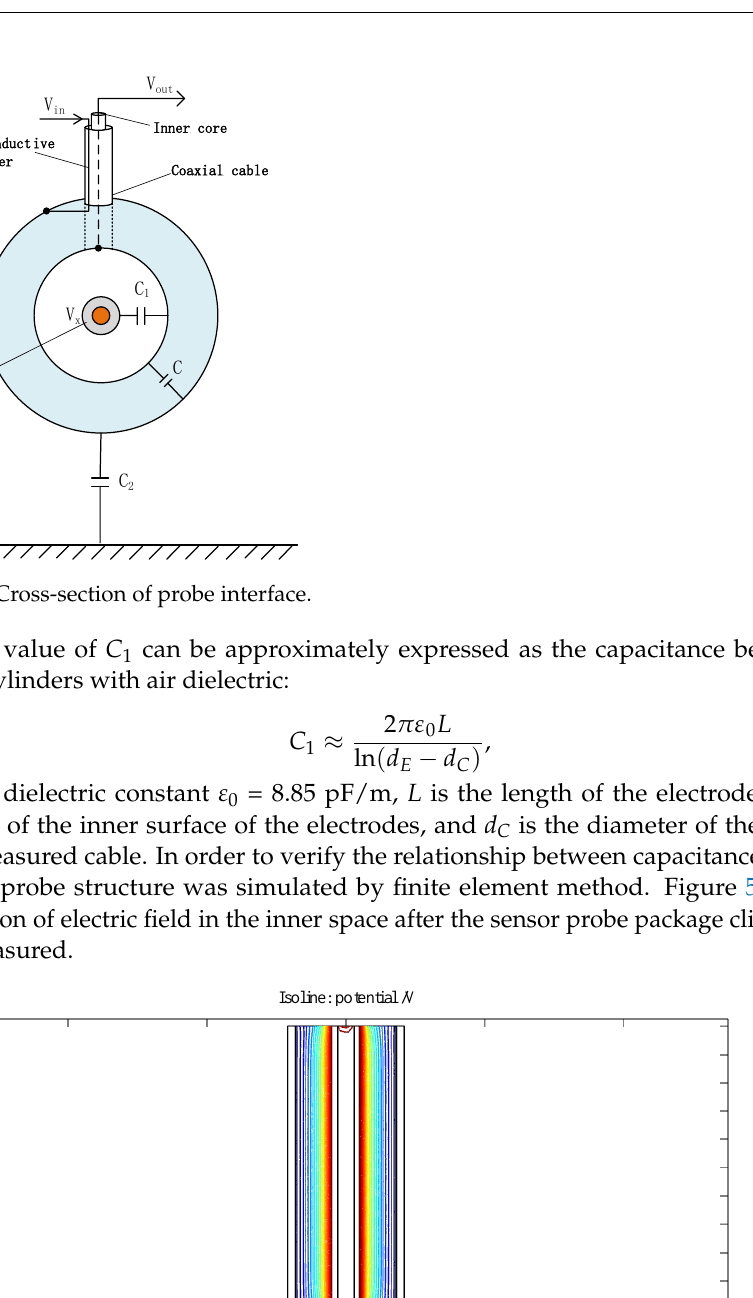
Figure 6. Diagram of relationship between sensor capacity and electrode length. Figure 7. Diagram of relationship between sensor capacity and electrode inner diameter. According to the previous discussion, the coupling capacitance C 1 between the inner pole plate of the probe and the cable to be measured is not only an important parameter